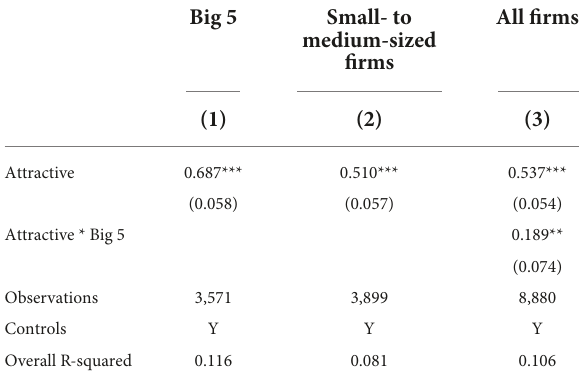
TABLE 5 The effect of attractiveness on the tendency to hire a candidate in Big 5 vs. other firms.